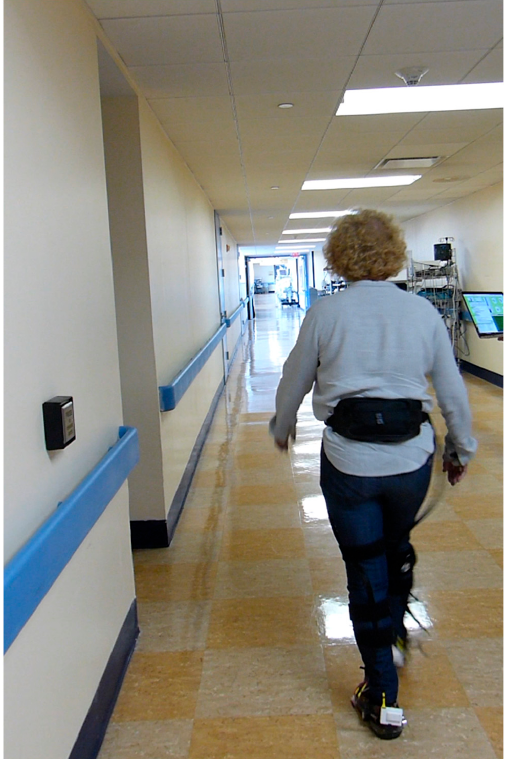
Figure 1. Participant walking while wearing custom-engineered footwear developed in the Co- lumbia University Robotics and Rehabilitation Laboratory. Each participant completed a 100-m- long